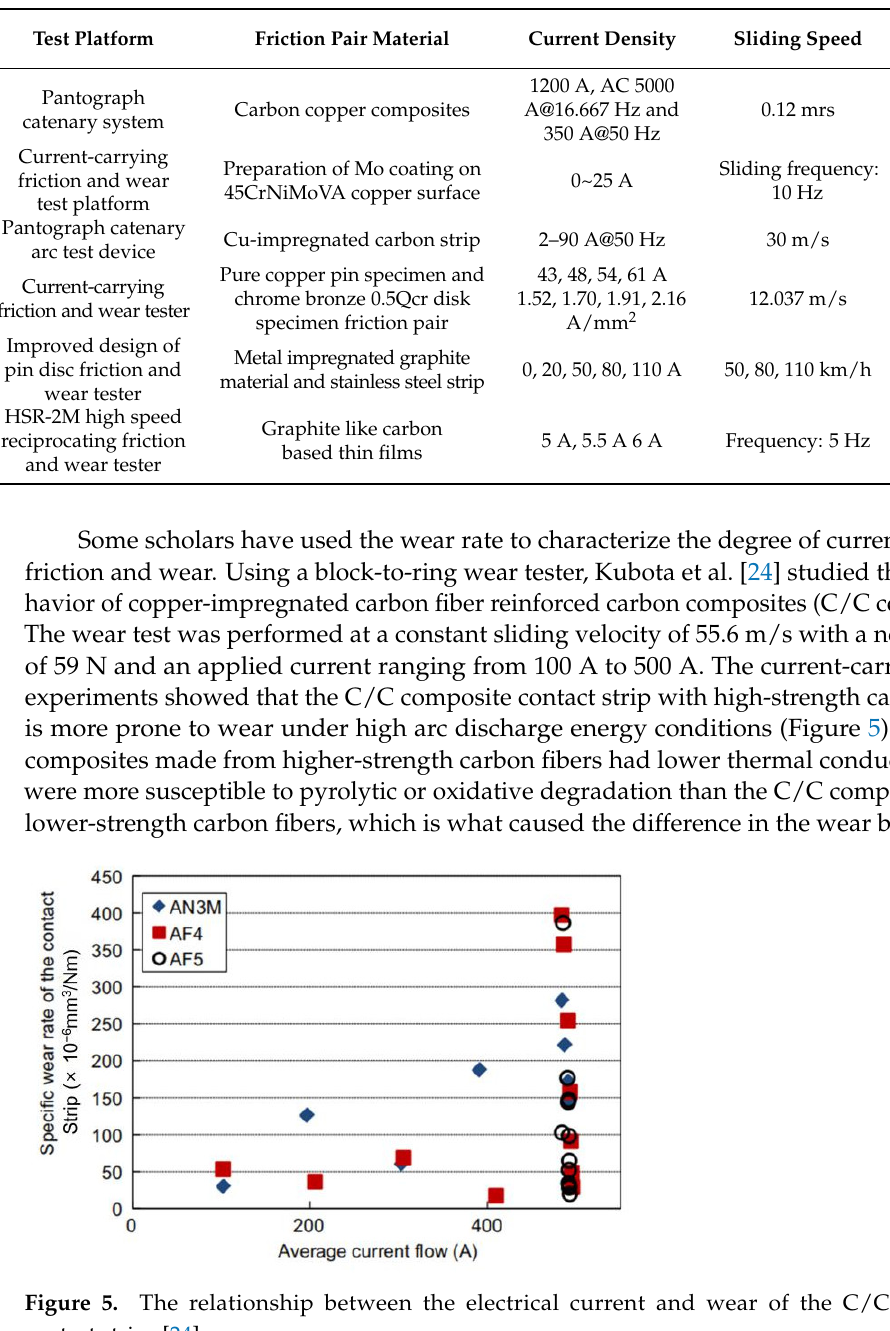
Table 1. The current density related research.